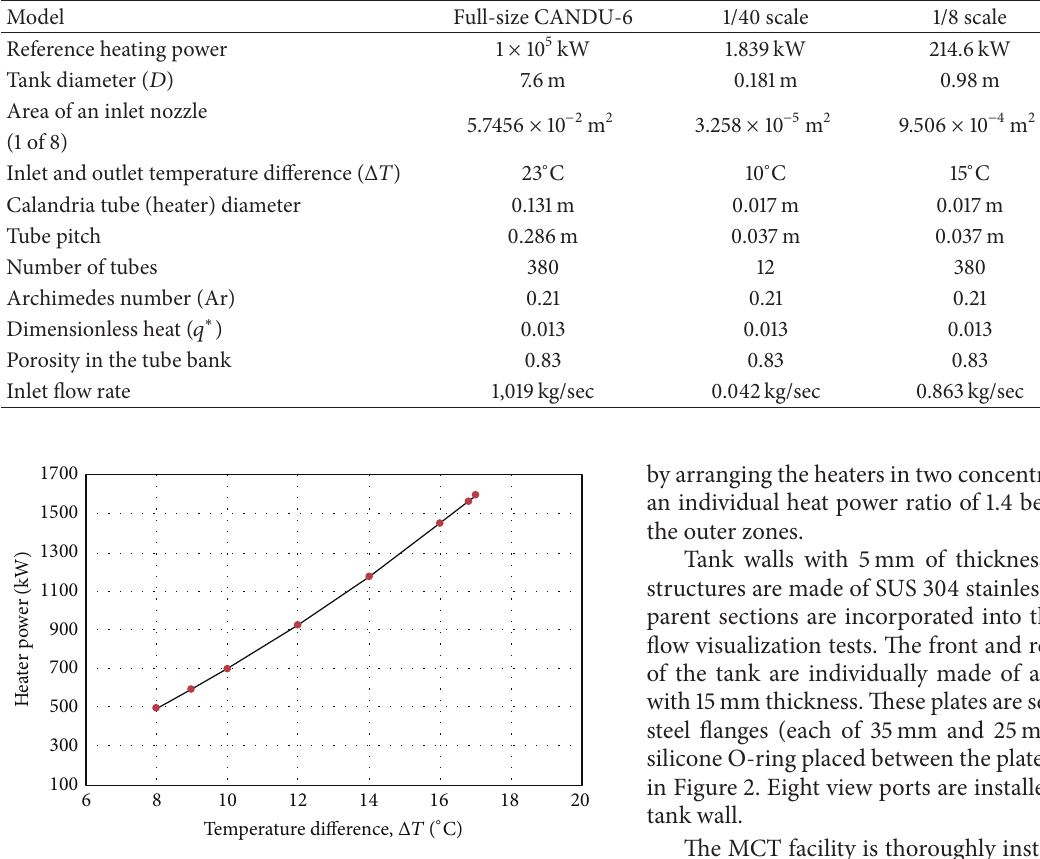
Table 1: Comparison of the main design parameters for the full-size and scaled-down models.